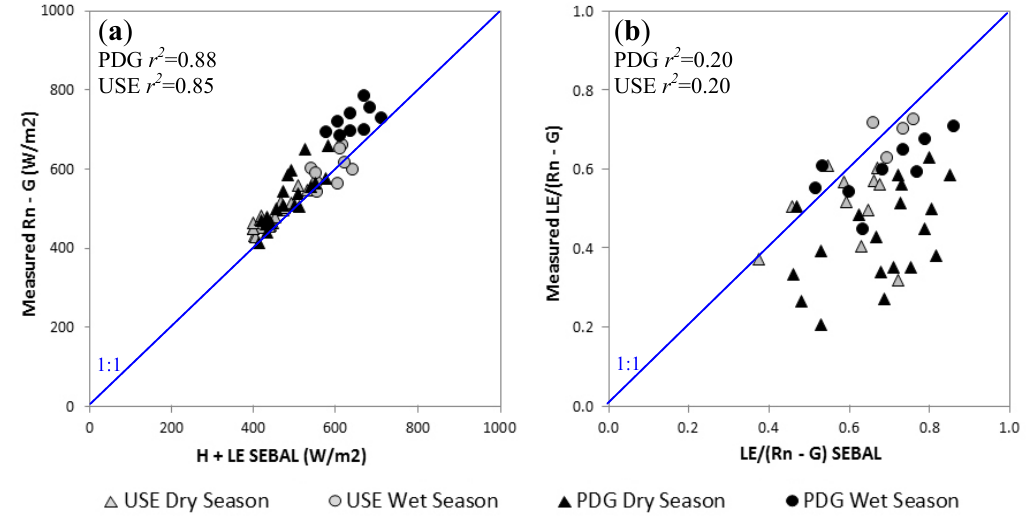
Figure 3. Analysis of the instantaneous on-overpass (11:30am LT) energy balance closure ( a ) and evaporative fraction for blue-sky days ( b ) in areas of savannas (PDG site) and sugarcane croplands (USE